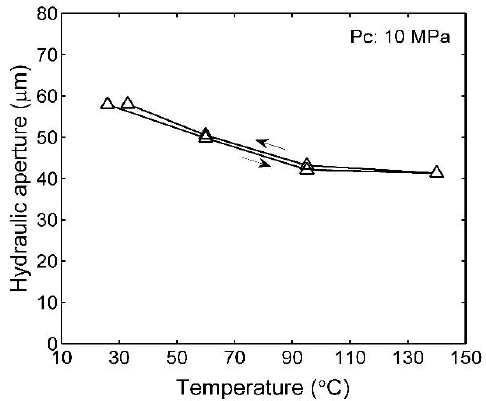
Figure 4. Hydraulic fracture aperture as a function of temperature at constant pore pressure (1 MPa) and constant confining pressure (10 MPa).